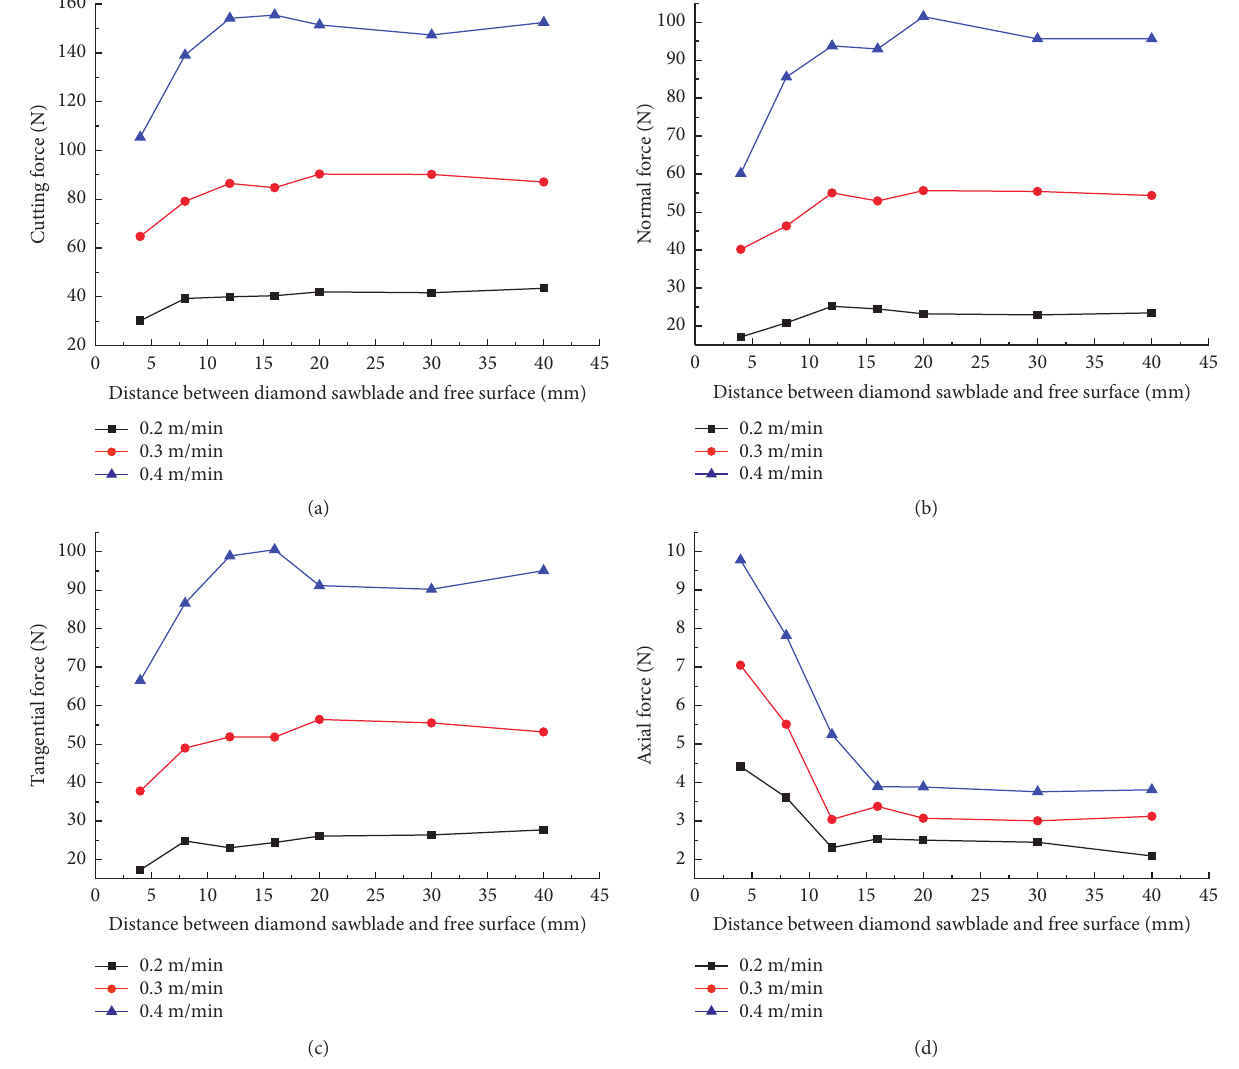
Figure 10: The curves of the force of the diamond sawblade cutting rock at fixed depth and the distance between the sawblade and rock free surface. (a) Variation curve of average cutting force and the distance between the sawblade and free surface. (b) Variation curve between average normal force and distance between the sawblade and rock free surface. (c) Variation curve between average tangential force and distance between the sawblade and free surface. (d) Variation curve between average axial force and the sawblade to rock free